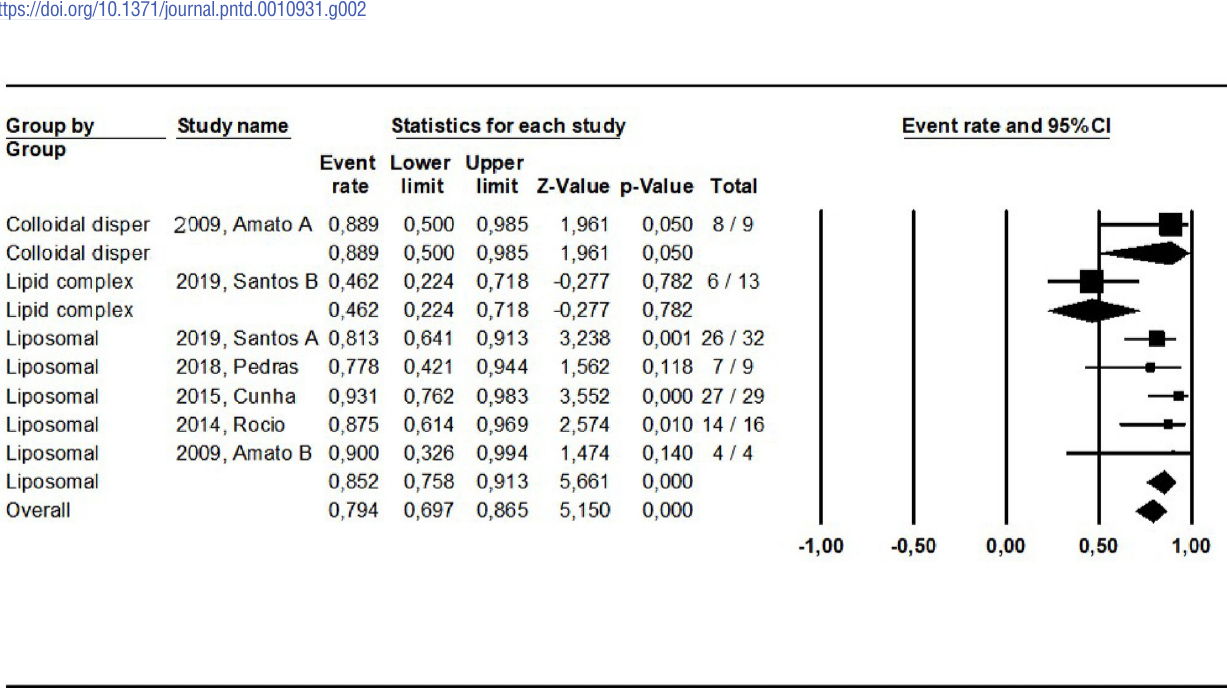
Fig 3. Pooled cure rate including all patients treated with lipid formulations of amphotericin B in the reviewed studies using a mixed effect analysis. Colloidal disper: colloidal dispersion. Liposomal : Liposomal amphotericin B. Different interventions in the same study were indicated by letters.